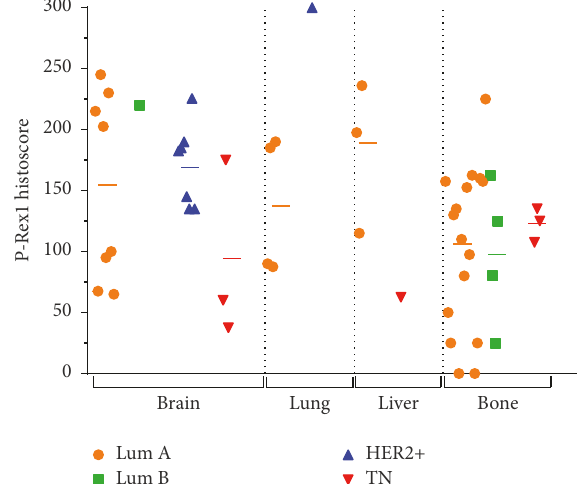
Figure 3: P-Rex1 expression in metastatic breast cancers. P-Rex1 expression is lower in bone metastases compared to brain, lung, and liver metastases. Each point represents mean P-Rex1 histoscore from two pathologists. Horizontal bars indicate mean histoscore for each receptor subtype within each metastatic site. Figure 4: P-Rex1 expression in matched primary breast tumors and metastases. Each point represents mean P-Rex1 histoscore from two pathologists. Lines indicate matching pairs and metastatic